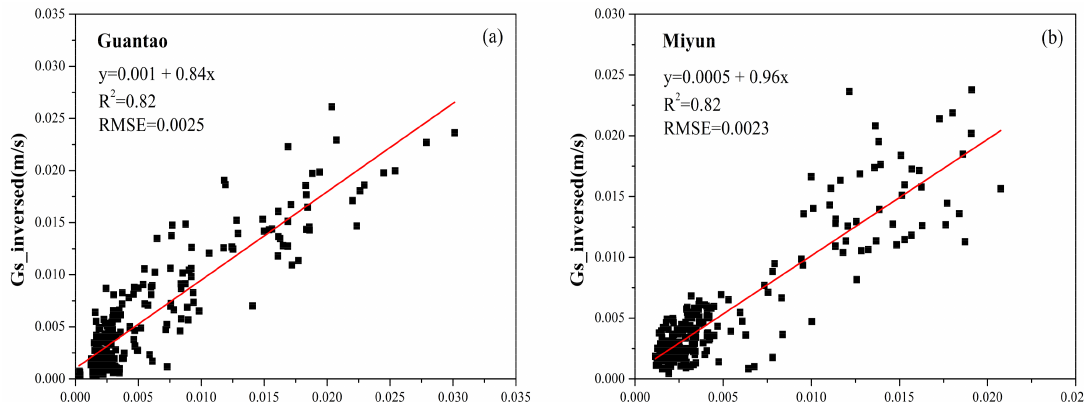
Figure 4. Comparisons of surface conductance between inverted results of the P-M equation and estimated results of the surface conductance model at the Guantao ( a ) and Miyun ( b ) stations. The red line is fitting line. The black boxes indicate values of surface